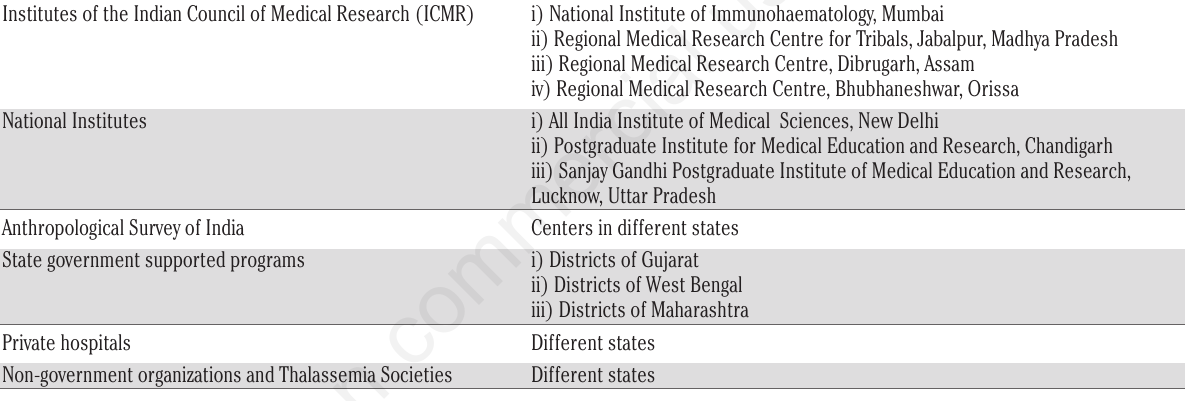
Table 1. Major programs for awareness and screening for b -thalassemias.